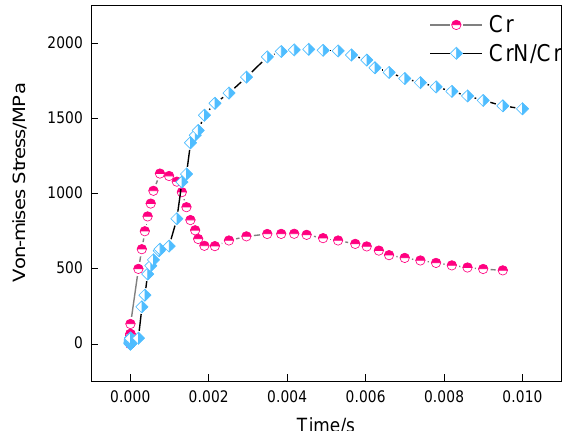
Figure 8. Variation curves of maximum stress in inner bore of Cr coating barrel and CrN/Cr composite coating barrel with gun firing time.